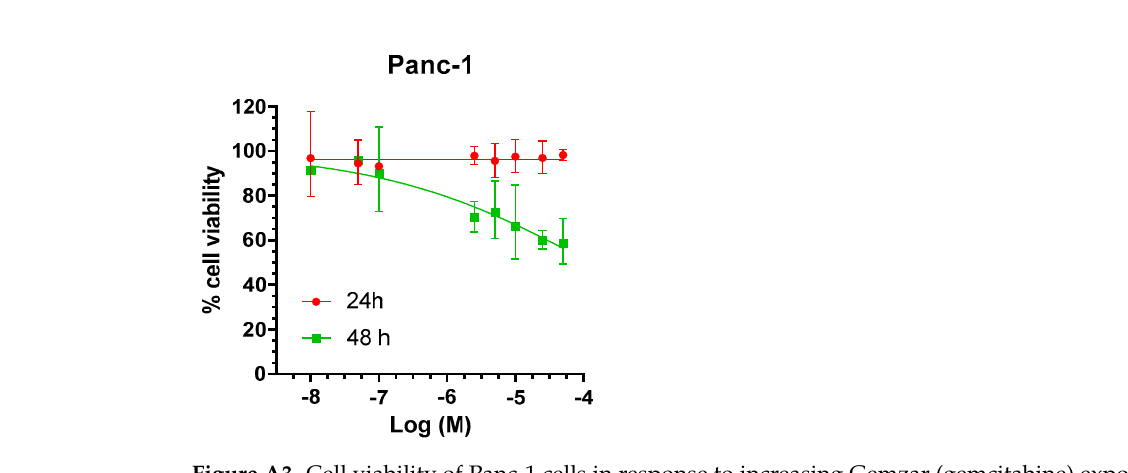
Figure A2. Cell death of Panc-1 cells treated with 10 µM AS-10 required longer than 6 h of exposure. ( A ) Live and dead Annexin V assay. Bottom-left quadrant represents healthy cells; bottom-right quadrant represents early apop- totic cells (Annexin V (+) and 7-ADD (-)); top-right quadrant represents late apoptotic/dead cells (Annexin V (+) and 7-ADD (+); Top-left quadrant represents cells that died of necrosis (Annexin V (-) and 7-ADD (+). ( B ) Fluorescence microscopy Live and Dead analysis using calcein-AM and ethidium bromide. Green indicates live cells and red indi- cates dead cells.